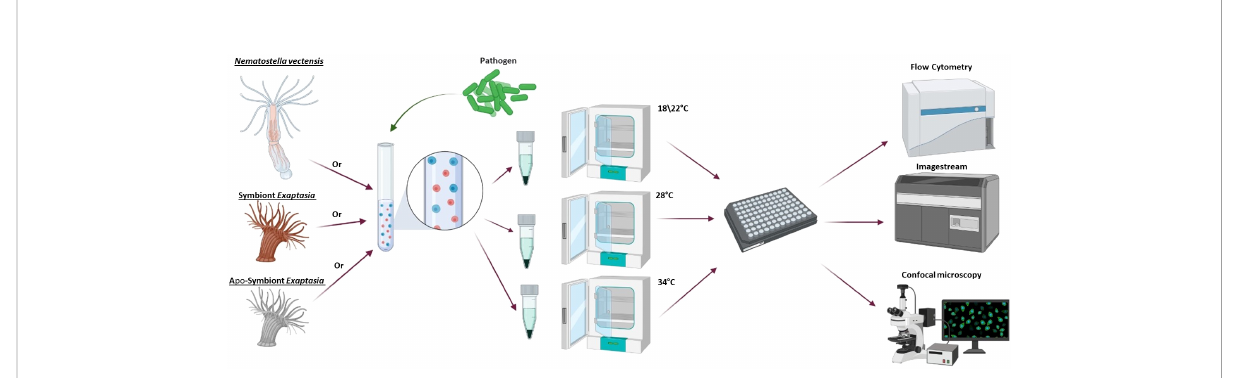
FIGURE 1 General work fl ow for heat stress experiments. First, cells were dissociated from one of the following models: N. vectensis , symbiotic E. diaphana or aposymbiotic E. diaphana . The cells were exposed to one of the phagocytic challenges ( S. aureus or DQ ™ ovalbumin) or pinocytosis assay (dextran), then divided into overnight incubators at different temperatures to test the response to heat stress. Following overnight incubations, the cells were concentrated in a 96-well plate and analyzed by imaging fl ow cytometry and fl uorescent confocal microscopy. Diagram was created with BioRender